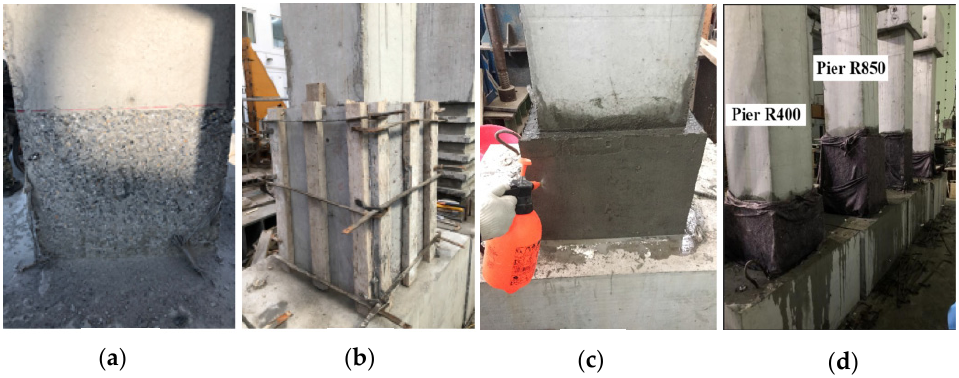
Figure 10. Strengthening RC piers using UHPFRC jacketing. ( a ) Surface preparation of the column, ( b ) casting the UHPFRC jacket, ( c ) casted UHPFRC jacket and ( d ) curing the UHPFRC jacketed columns ([90]—Elsevier Copyright). Table 3. Summary of the studies on combined axial and flexural strengthening using UHPFRC.